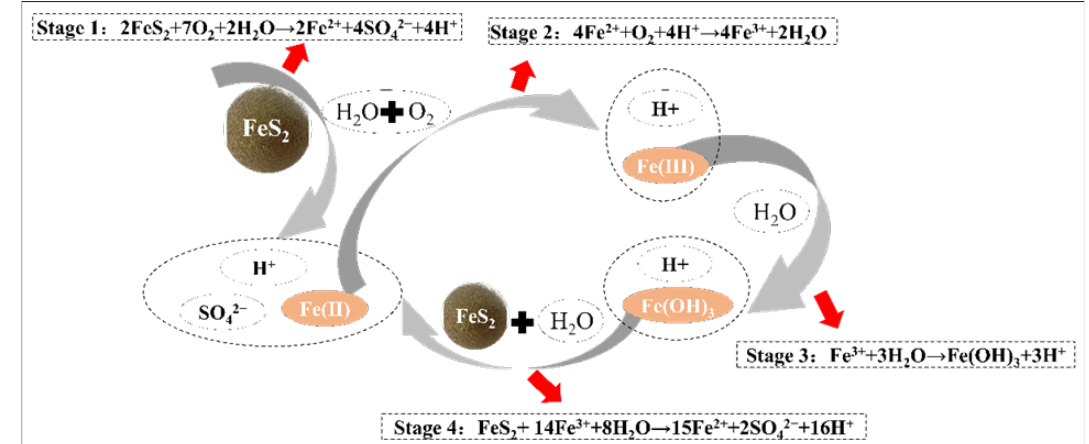
Figure 1. The schematic diagram of acid mine drainage (AMD ) .